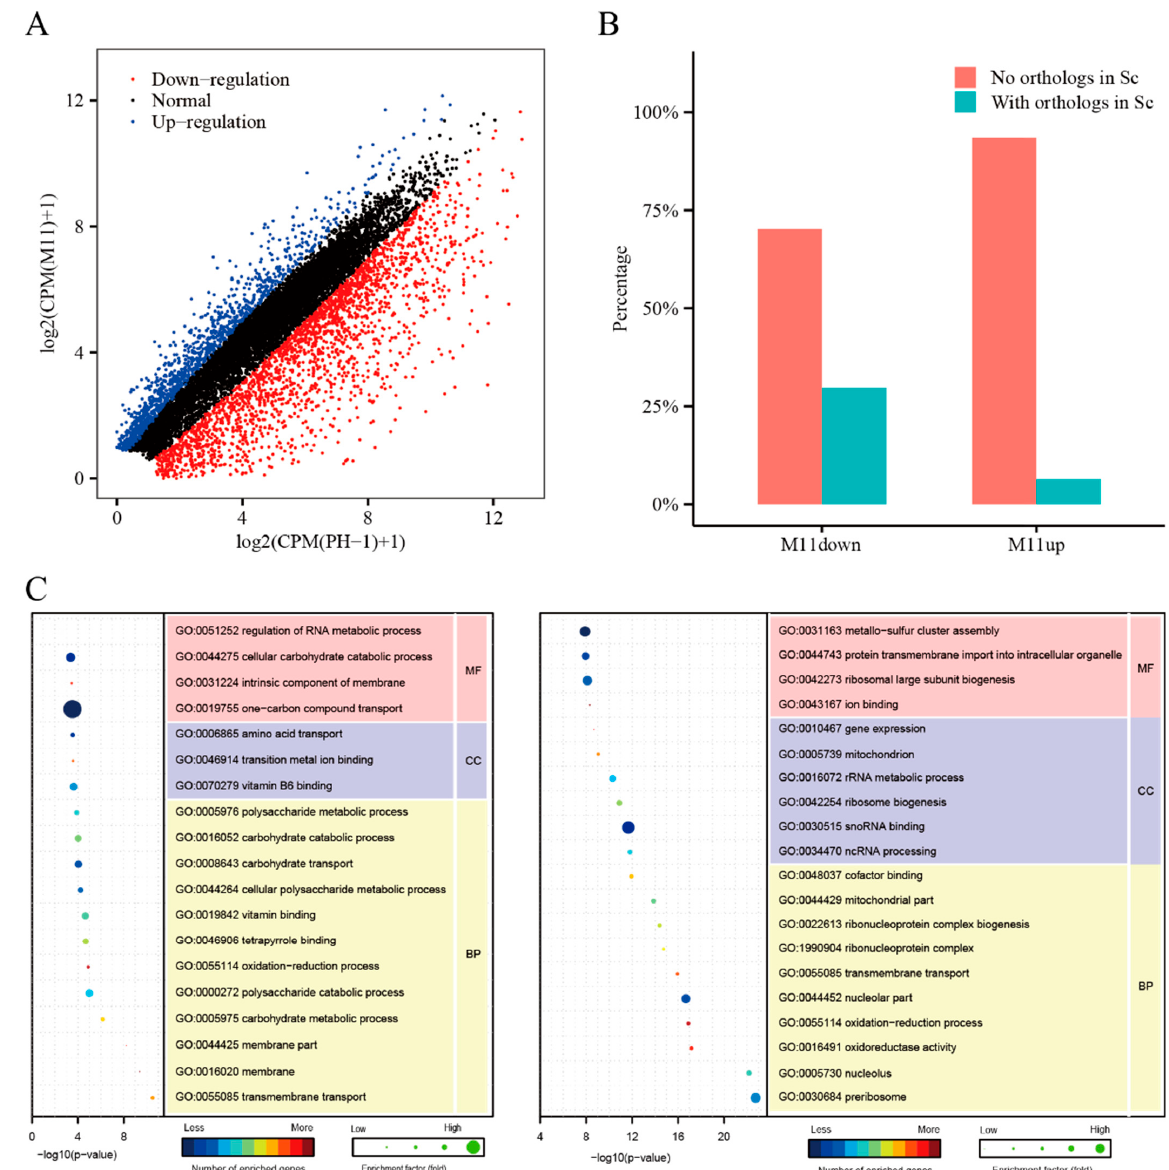
Figure 6. Assay for the role of FgCsn12 in transcriptional regulation. ( A ) Genes that were significantly increased (blue dots) and decreased (red dots) over two-fold in the Fgcsn12 mutant in comparison with the wild type. The x-axis and y-axis are the logarithms of CPM (wild-type PH-1) + 1 and CPM (M11) + 1, respectively. ( B ) The proportion of downregulated genes and upregulated genes with or without orthologs in budding yeast. ( C ) GO enrichment analysis of the upregulated and downregulated genes in M11. BP, MF, and CC represent biological process, molecular function, and cellular component, respectively.